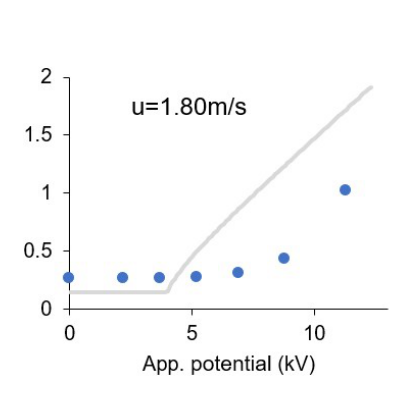
Figure 13. Comparison between the experimental data at u = 1.8 m/s (blue dots) and the fit at u = 0 (grey line).